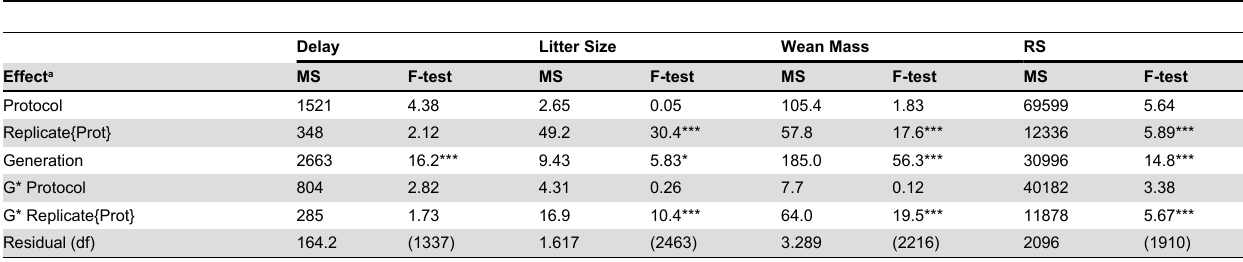
Table 5. Statistical tests of effects of breeding protocol, replicate, and generation on continuous measures of reproductive performance of pairs, based on ANOVAs from generalized linear models.